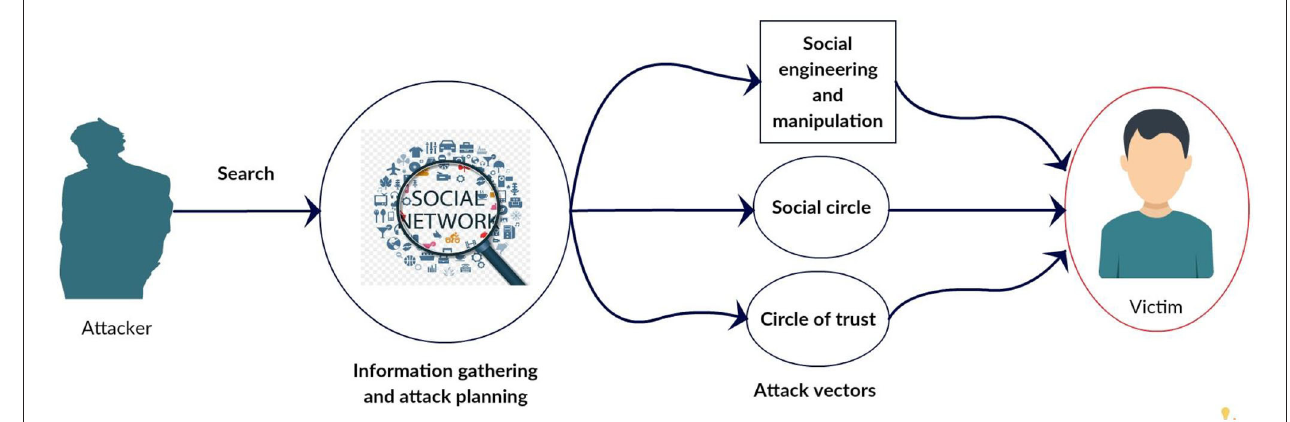
FIGURE 2 | The user attack graph